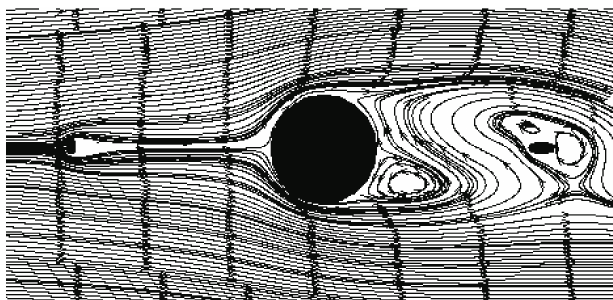
Figure 5. Type-I circular cylinder as a passive control in front, while an elliptical cylinder as a passive control at the rear of the circular cylinder.